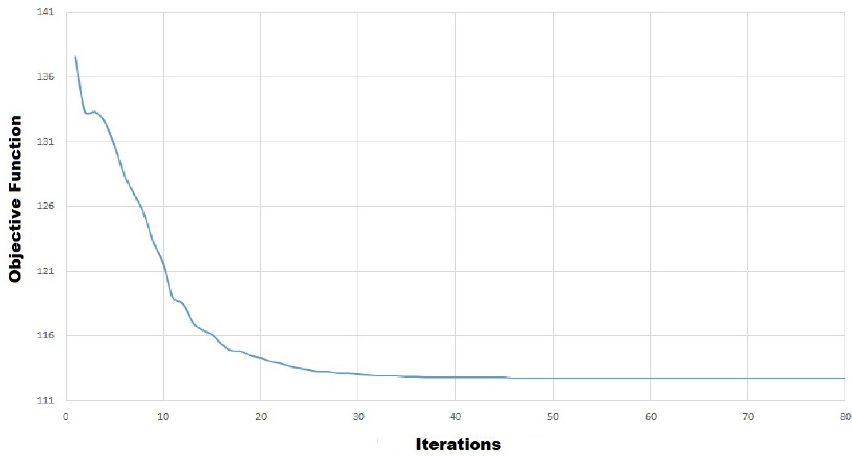
Figure 8. Objective function system III.